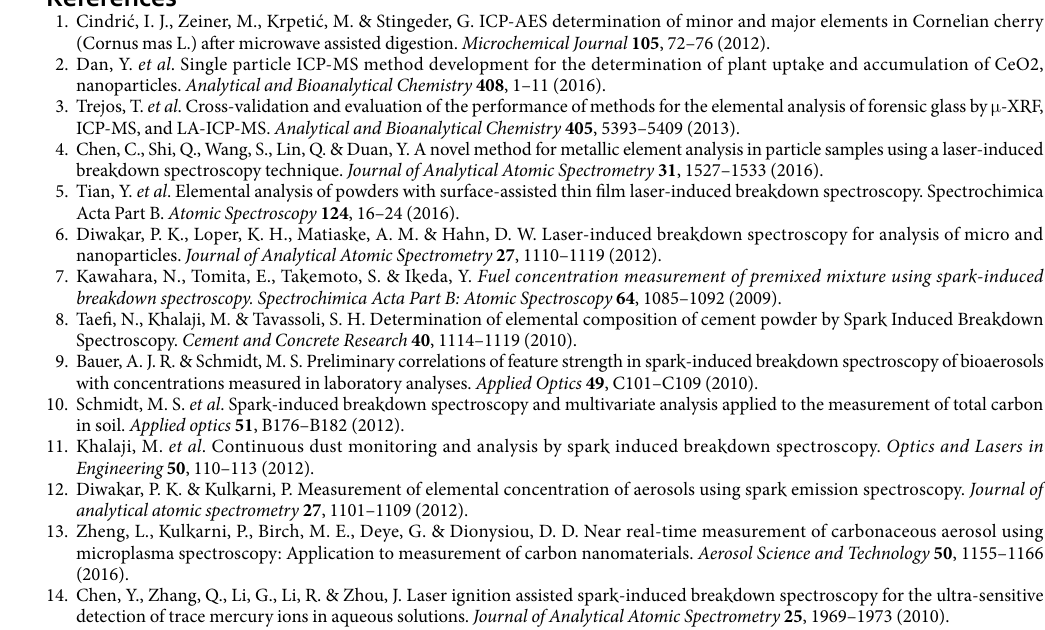
7 Scientific RepORts | (2018) 8:1868 | DOI:10.1038/s41598-018-20073-1